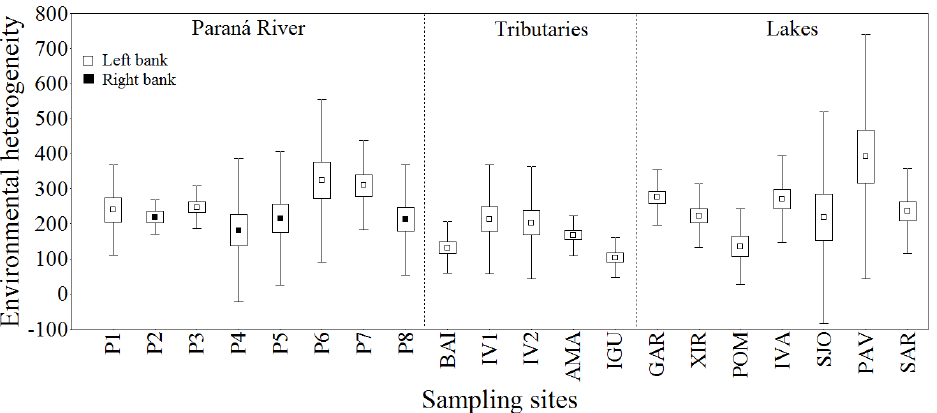
Figure 2. Mean values, deviation and standard error of environmental heterogeneity of the sampling sites in the river-floodplain system of the Upper Paraná River.